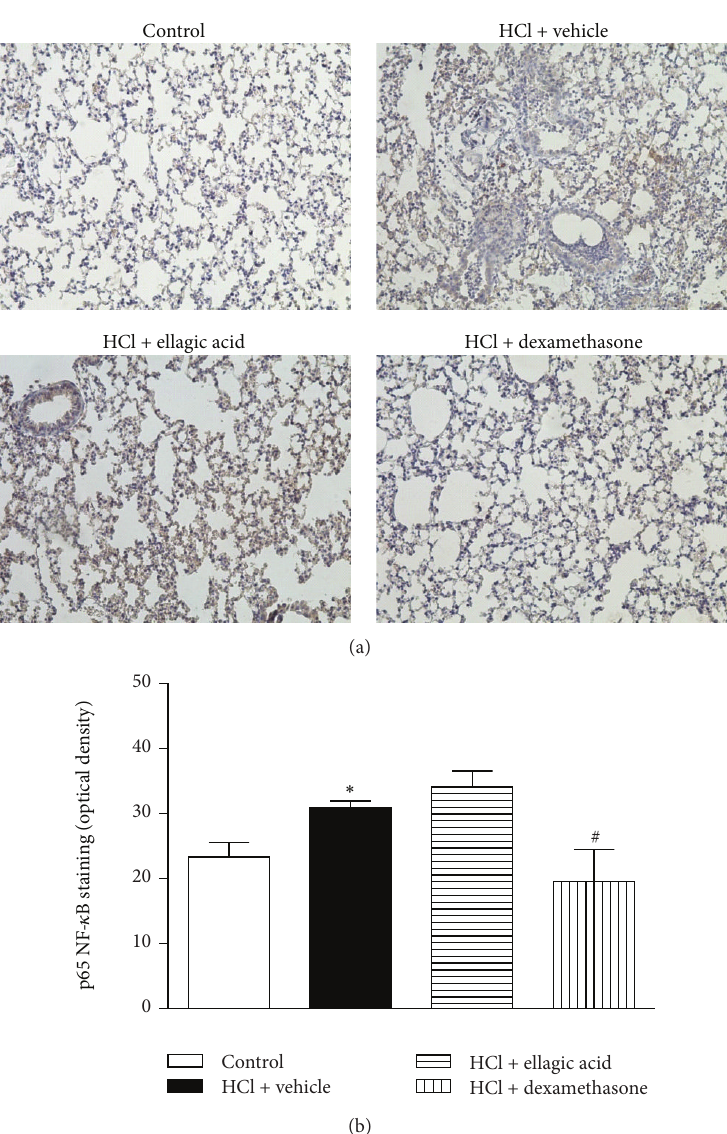
Figure 4: Effect of therapeutic treatment with ellagic acid on the activation of p65 NF- 𝜅 B. Representative images of phospho-p65 NF- 𝜅 B immunohistochemistry staining of control, HCl + vehicle group, HCl + ellagic acid group, and HCl + dexamethasone group (magnification: × 200) (a). The mean intensity of phospho-p65 NF- 𝜅 B staining was determined from image analysis and represented as arbitrary units (b). The analyses of lung were carried out in the peak of inflammation (12h). Values represent the mean ± SEM ( 𝑛 = 4 per group) for immunohistochemical analysis. ∗ 𝑃 < 0.05 compared with control group; # 𝑃 < 0.05 compared with HCl + vehicle